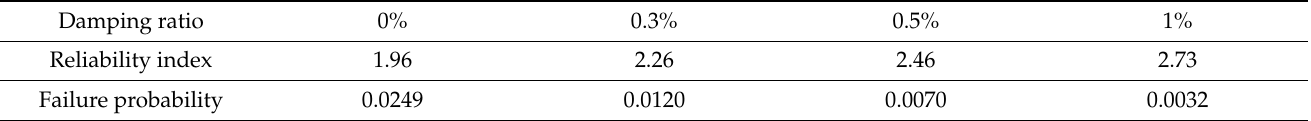
Table 13. Flutter failure probability corresponding to different damping